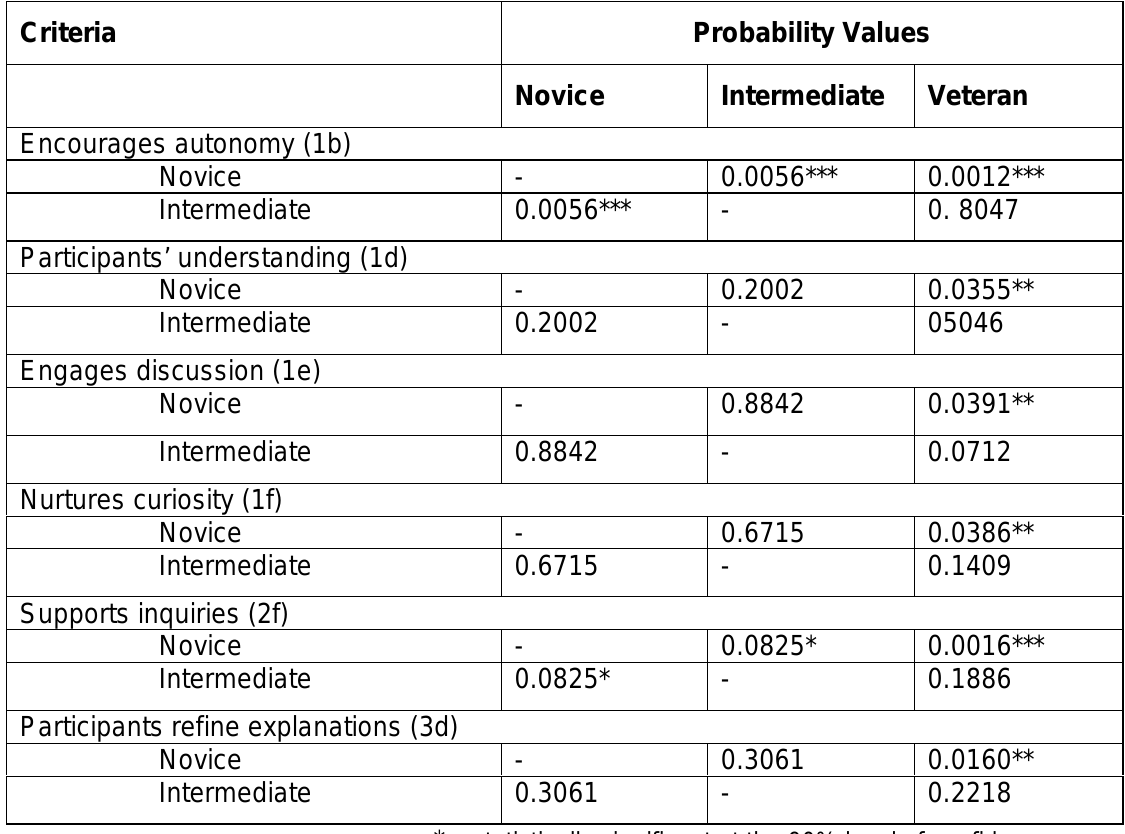
Probability values which indicate statistically significant differences between mean scores for criteria observed during facilitation of Family Maths